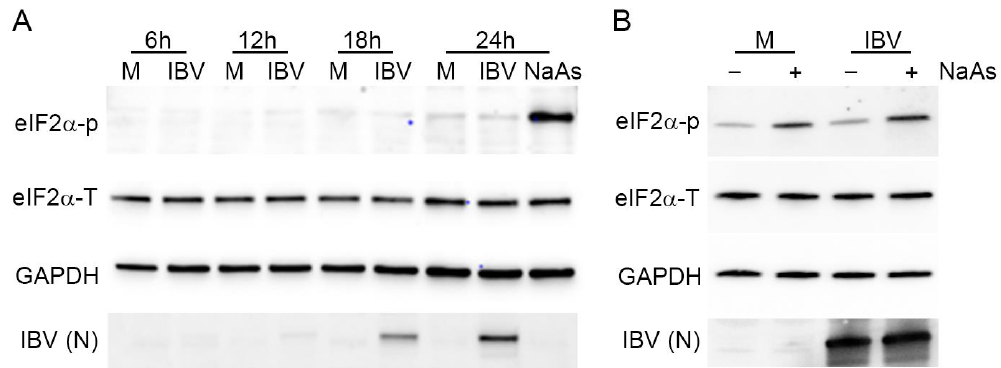
Figure 9. Stress granule formation and translational shut-off during IBV replication are independent of eIF2α phosphorylation. ( A ) Vero cells were mock infected or infected with IBV. At 23 hpi, cells were treated with sodium arsenite (NaAs), to induce phosphorylation of eIF2α. At 6, 12, 18 and 24 hpi, cells were washed and lysed. Samples were then separated by SDS-PAGE and transferred to nitrocellulose. Total eIF2α (eIF2α-T) was detected with anti-eIF2α, phosphorylated eIF2α (eIF2α-p) was detected with anti-eIF2α-p. IBV proteins were detected using an anti-IBV antibody, with a band corresponding to the IBV nucleocapsid protein shown (IBV (N)) and an anti-GAPDH antibody was used as a loading control. ( B ) Vero cells were mock infected or infected with IBV. At 23 hpi, where indicated, cells were treated with NaAs. Cells were lysed at 24 hpi and processed and labelled as in ( A ). Blots are representative of three independent replicates.